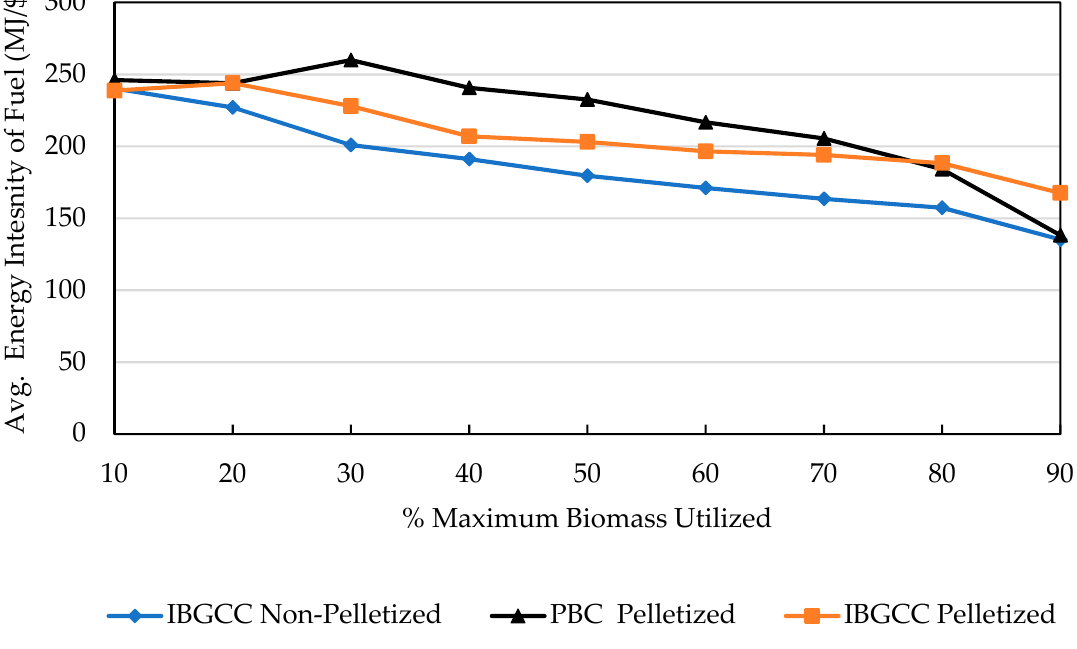
Figure 3. Fuel intensity as a function of percent maximum biomass utilized in BECCS.